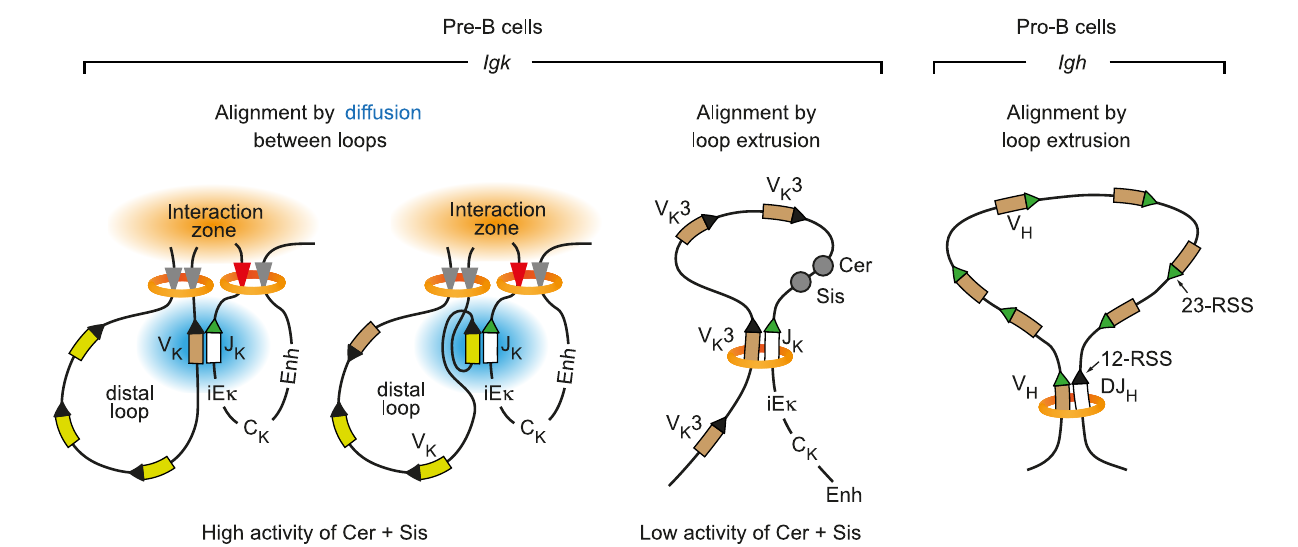
Fig. 7 | Different folding principles leading to convergent alignment of RSS sequencesatthe Igk and Igh loci. Schematicdiagramsdepictthedifferentfolding principles leading to a convergent alignment of RSS sequences during V gene recombination at the Igk and Igh loci. The convergent orientation of the 12-RSS (recognitionsignalsequencewitha12-bpspacer,blackarrowhead)oftheV K genes or D H segment and the 23-RSS (with a 23-bp spacer, green arrowhead) of the J K element or V H genes is essential for mediating RAG-dependent cleavage and recombination 21 . Cohesin (orange)-mediated loop extrusion across the entire Igh locusisresponsiblefortheconvergentalignmentoftheRSSsequencesofV H genes